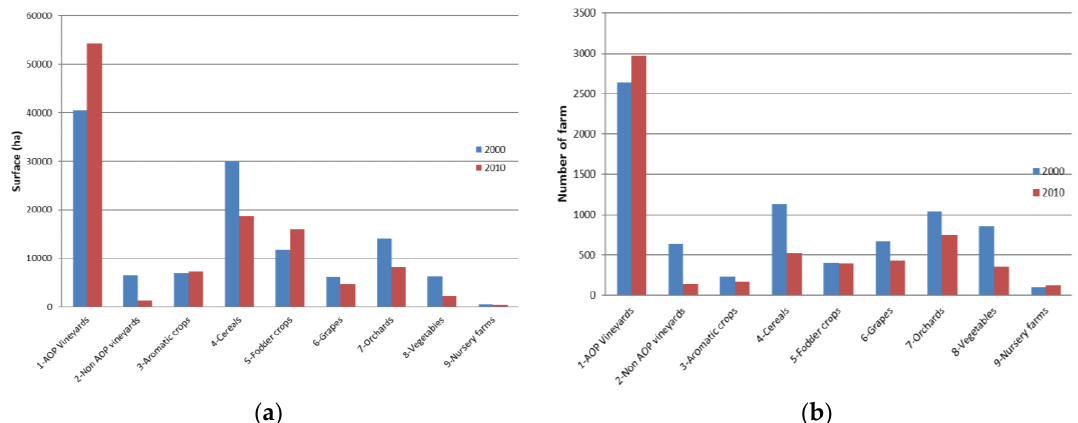
Figure 3. Aggregated farming system changes from 2000 until 2010 for the whole Vaucluse department in terms of ( a ) surface and ( b ) number of farms.